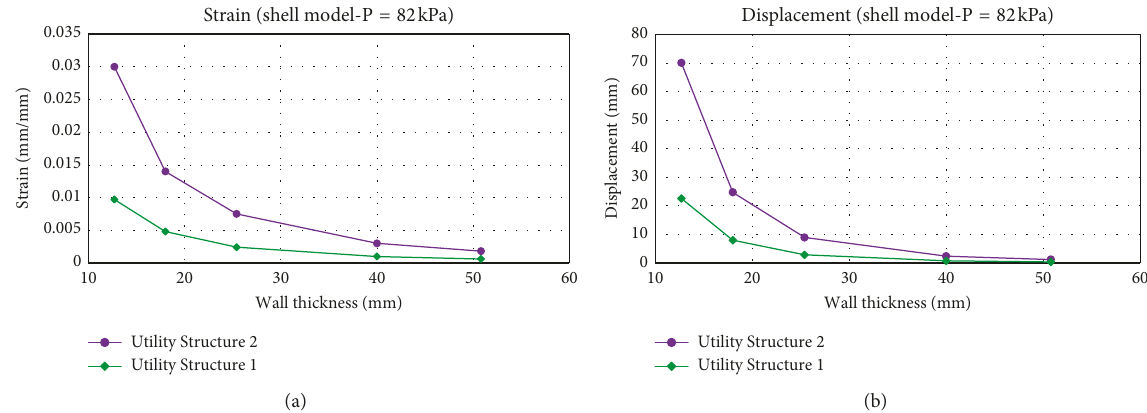
Figure 12: (a) Strain and (b) displacements of Utility Structure 1 and Utility Structure 2 with a lateral pressure of adjacent soil of 82kPa as a function of their wall thickness.